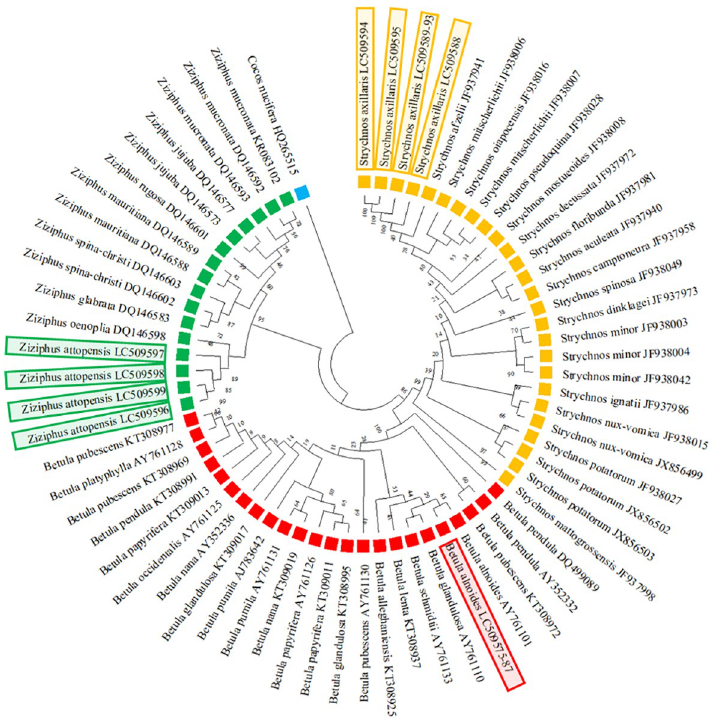
Fig 3. Neighbor-joining (NJ) tree of Betula (red), Strychnos (yellow), Ziziphus (green) with Cocos nucifera (blue) as the out-group. Red, yellow, and green boxes represent the identified species in our research. Numbers after each species refer to their GenBank accession number. A dendrogram was constructed with MEGA X version 10.0.5 software based on the aligned nucleotide sequences of the ITS2 region. The NJ bootstrap support values are shown for each